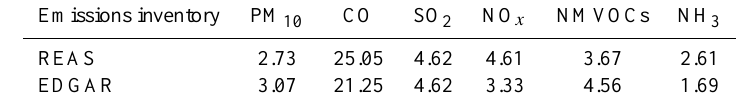
Table 1. List of total emissions for major pollutants from REAS and EDGAR over the model domain in July 2007. Unit is Tgmonth − 1 .